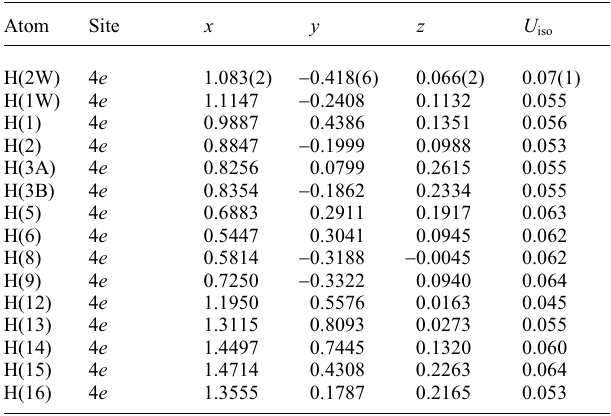
Table 2. Atomic coordinates and displacement parameters (in Å 2 )